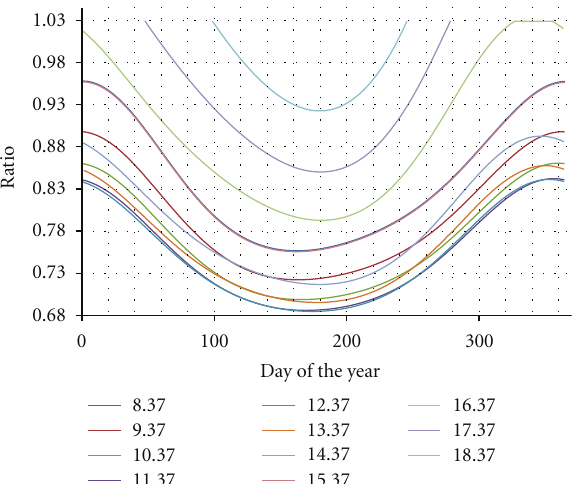
Figure 10: Ratio values of mirror 4 along the year (one-hour steps).